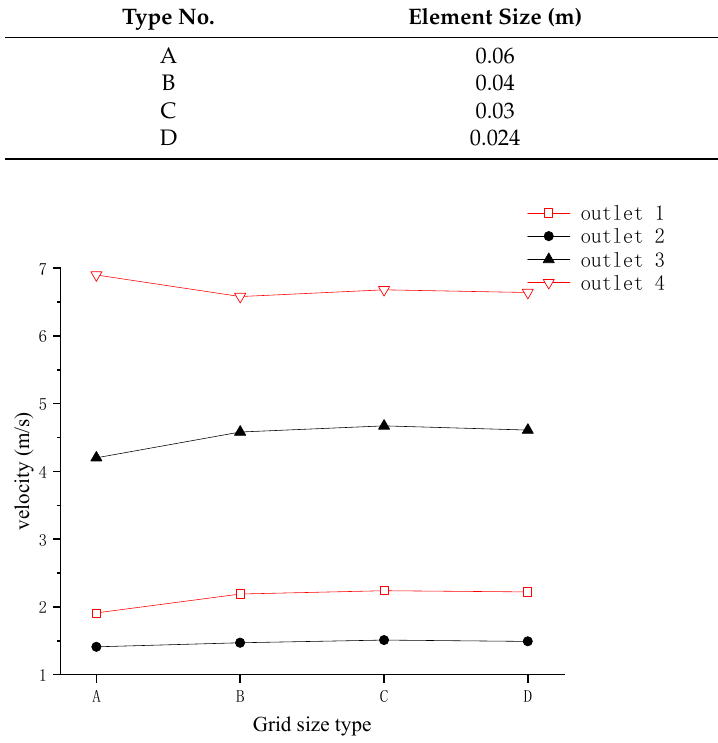
Table 3. Factors and levels of test. Type No.